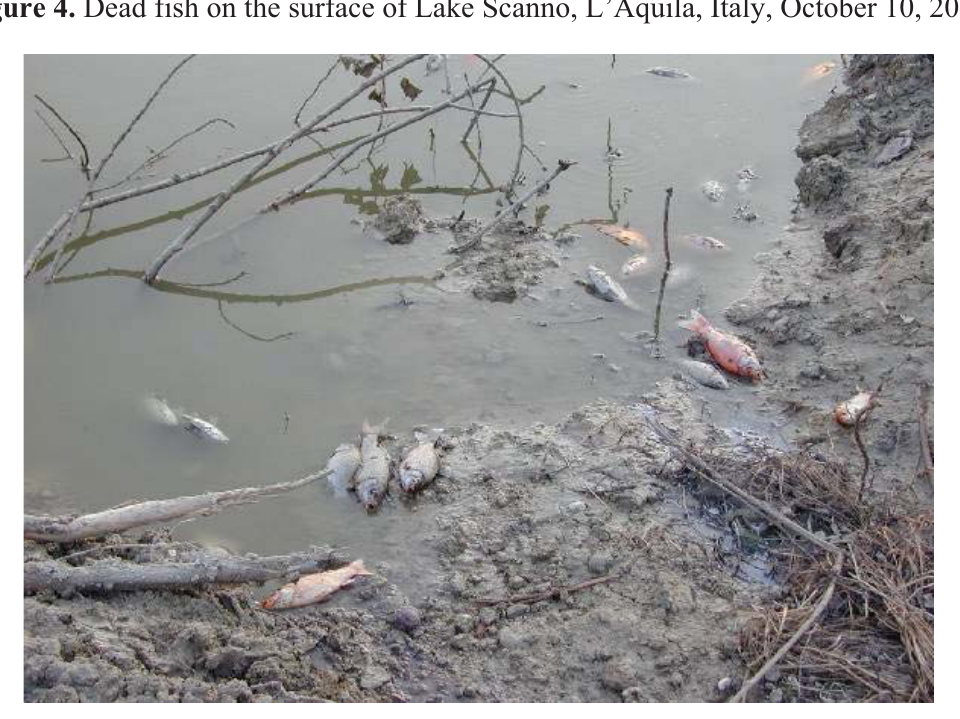
Figure 4. Dead fish on the surface of Lake Scanno, L’Aquila, Italy, October 10,